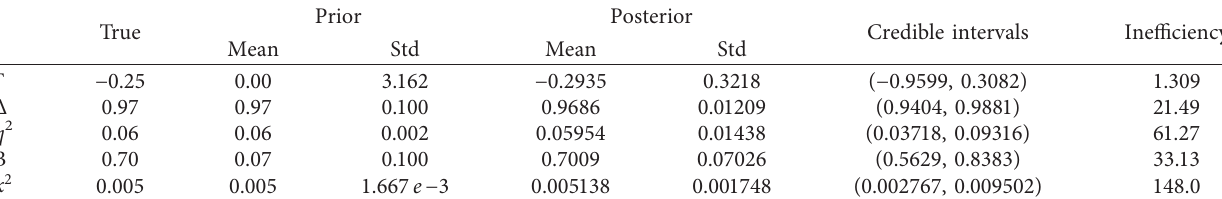
Table 6: The estimated result for MM model using simulated